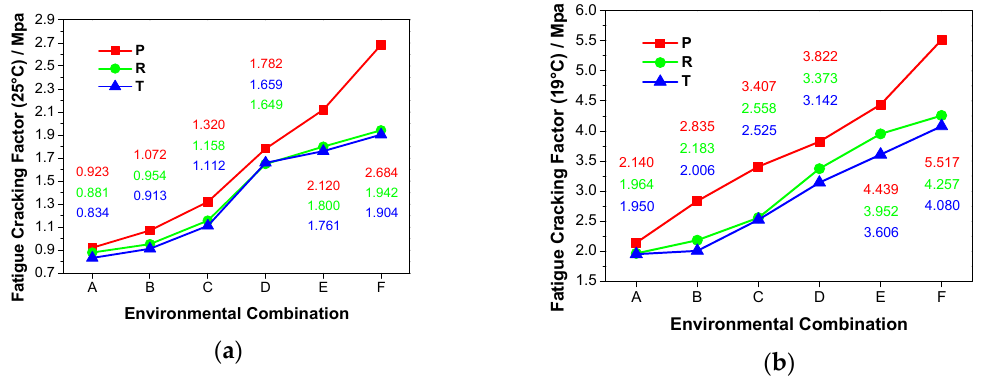
Figure 3. Fatigue cracking factors of three kinds of asphalts (P, R, and T) under different environmental combinations: ( a ) at 25 ◦ C; and ( b ) at 19 ◦ C. Table 8. r and ∆ r values of fatigue cracking factors at 25 ◦ C and 19 ◦ C.